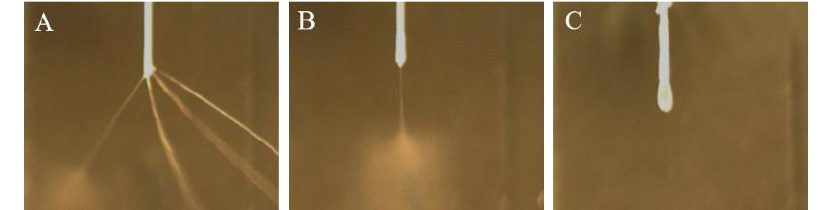
Figure 2. Three working modes of electrospinning process: ( A ) multi-jet mode ( V = 6 kV, Q = 30 µ L / min, Z = 30 mm), ( B ) single-jet mode ( V = 4.5 kV, Q = 30 µ L / min, Z = 30 mm), and ( C ) dripping mode ( V = 3.5 kV, Q = 30 µ L / min, Z = 30 mm).